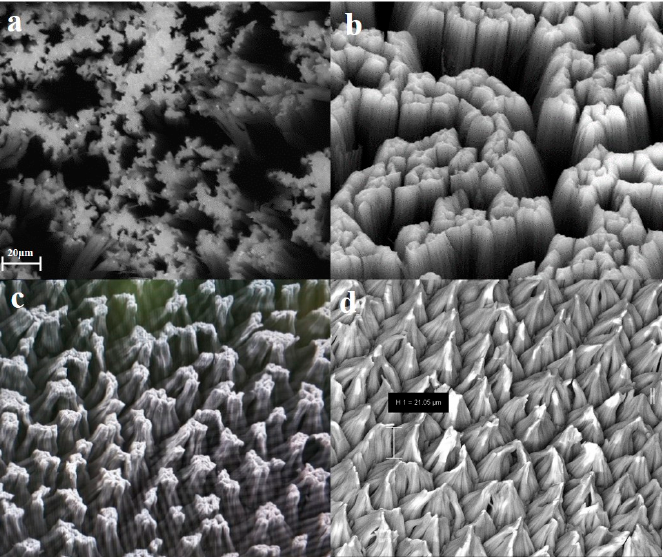
Figure 2. Scanning electron microscopy （ SEM ） diagram of the silicon wafer corroded in different time periods. ( a ) 15 min, ( b ) 1 h, ( c ) 2 h, and ( d ) 3 h.